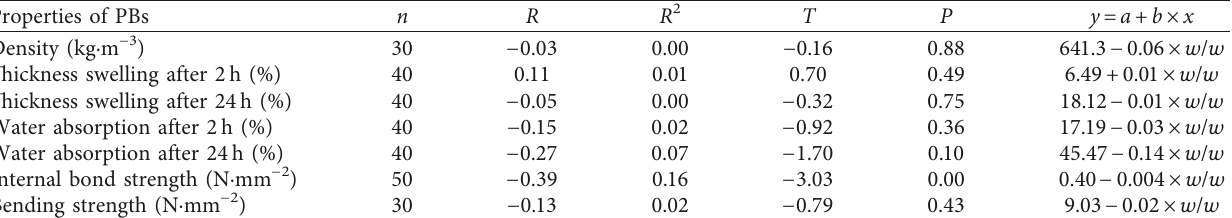
w w (ZnO) / (MUF) ) and the selected properties of →